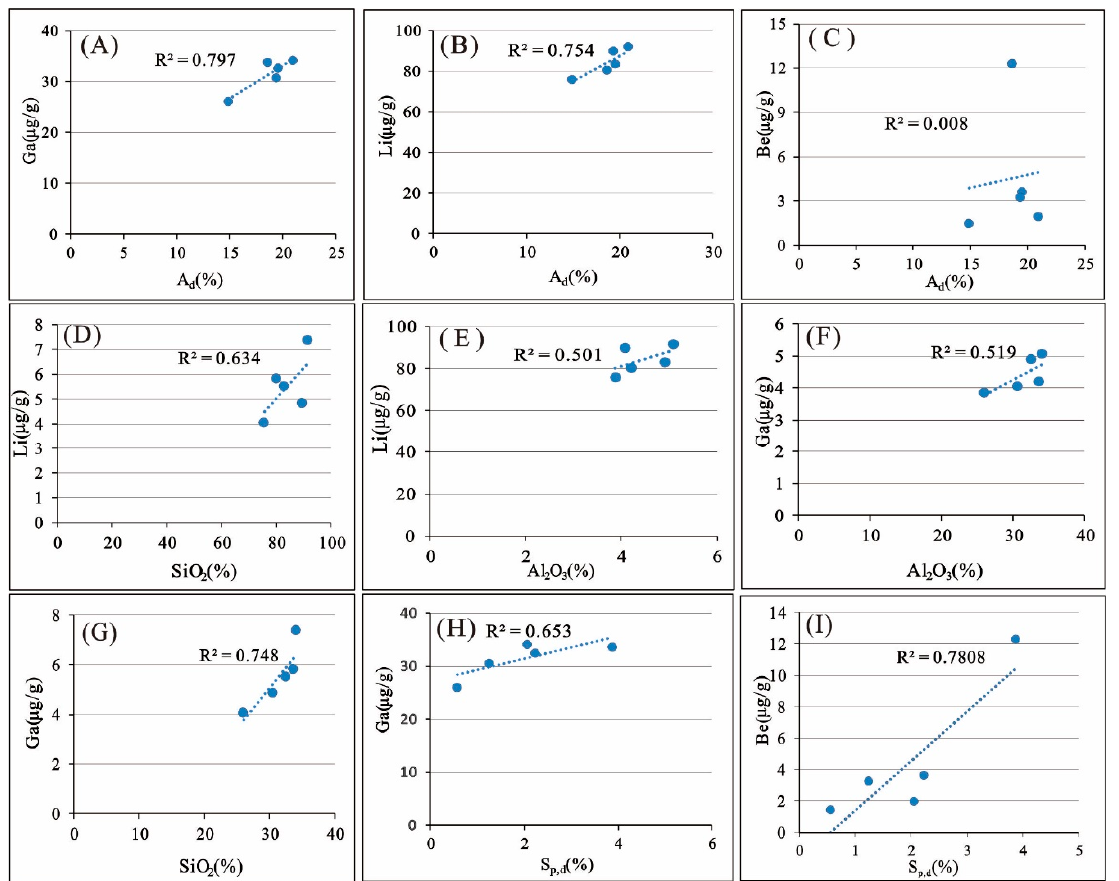
Figure 13. Relationship between several trace elements in the coal and ash yield, SiO 2 , Al 2 O 3 , or pyritic sulfur. ( A ) Plot of Ga and ash yield. ( B ) Plot of Li and ash yield. ( C ) Plot of Be and ash yield. ( D ) Plot of Li and SiO 2. ( E ) Plot of Li and Al 2 O 3. ( F ) Plot of Ga and Al 2 O 3. ( G ) Plot of Ga and SiO 2. ( H ) Plot of Ga and pyritic sulfur . ( I ) Plot of Be and pyritic sulfur .